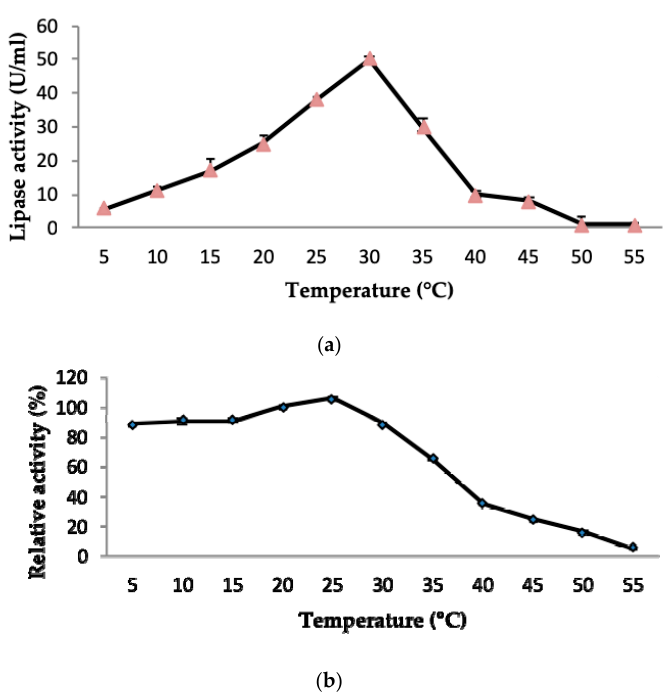
Figure 6. ( a ) Effect of temperature on purified LSK25 lipase activity. The lipase assay was carried out using olive oil as a substrate. Maximum lipase activity was observed at 30 ◦ C. ( b ) The effect of temperature on purified LSK25 lipase stability. The enzyme was incubated at various temperatures for 30 min and the assay was performed at the optimum temperature. Activity was calculated relative to 25 ◦ C as 100%. Error bars represent standard deviation ( n =